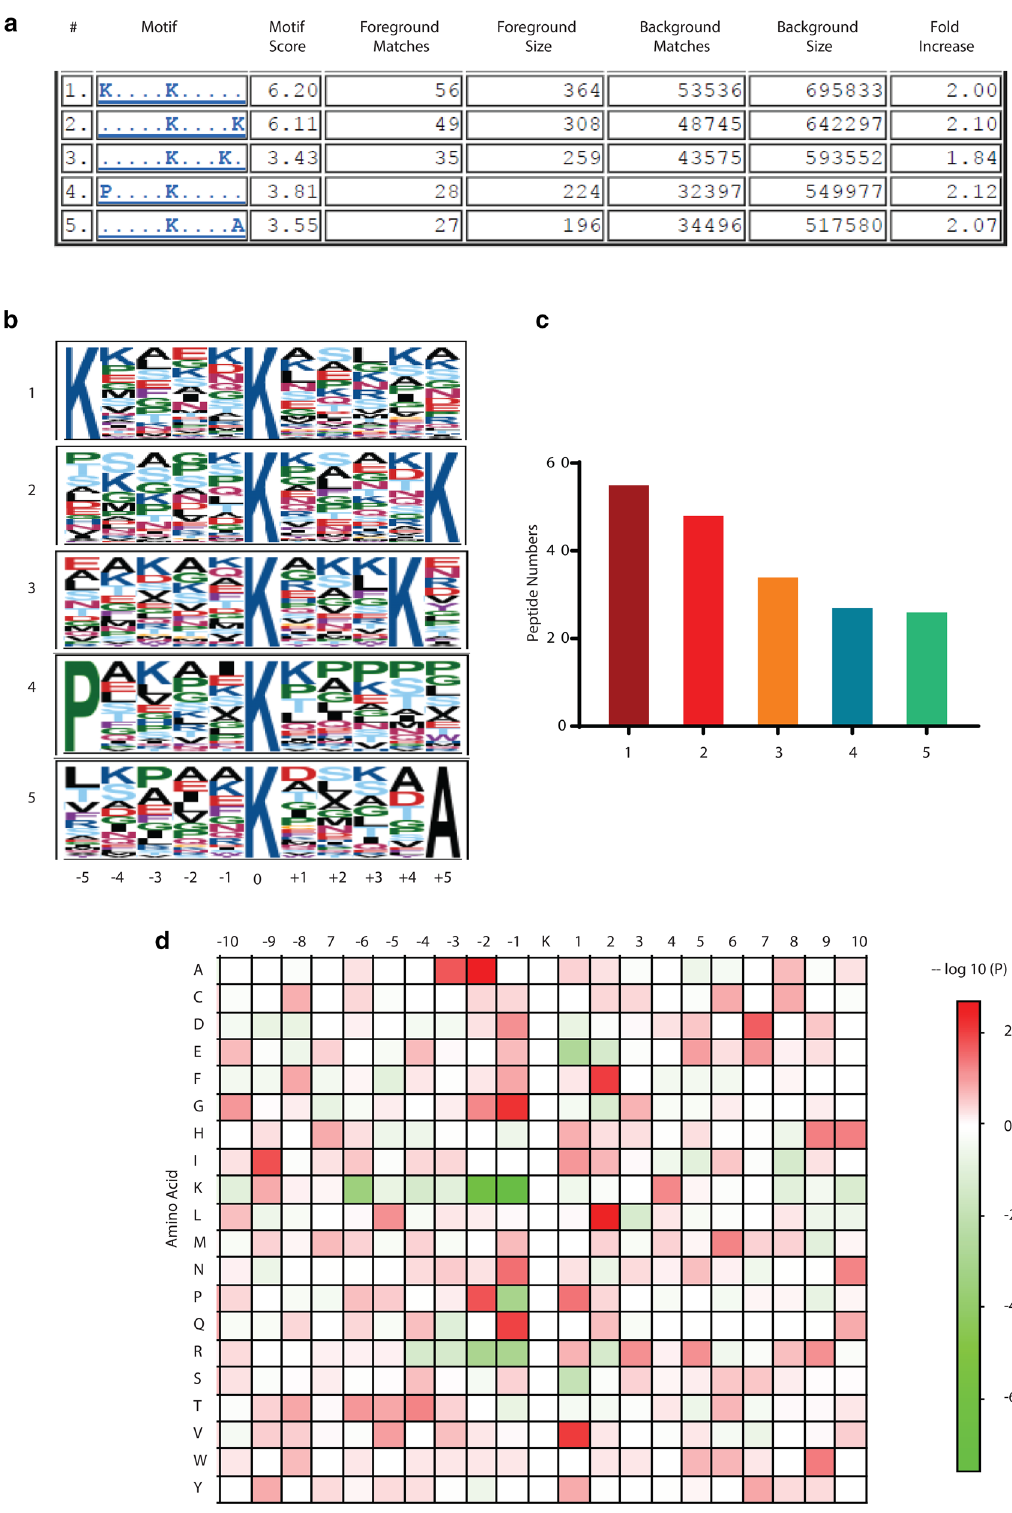
Figure 5. Properties of identified acetylated lysine peptides. ( a , b ) Acetylation motifs and conservation of acetylation sites identified by Motif-X. ( c ) Quantification of acetylation motifs identified by Motif-X. ( d ) Heat map of the amino acid compositions of the acetylated lysine sites showing the relative abundance of the adjacent 20 amino acids surrounding the acetylated lysine. The colors in the heat map represent the – log10 of P value (red shows over-representation, green shows